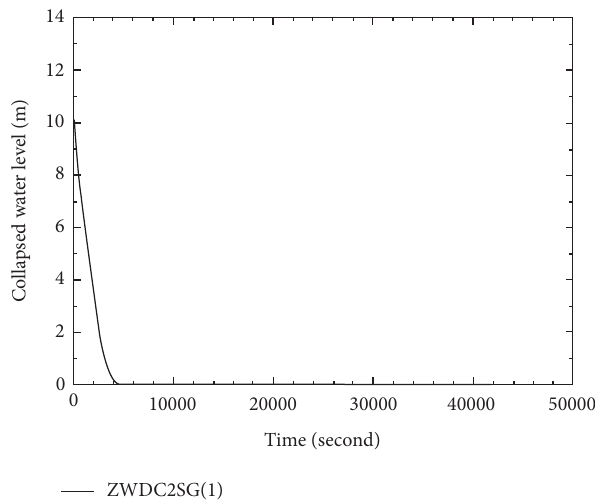
Figure 10: SG downcomer water level.